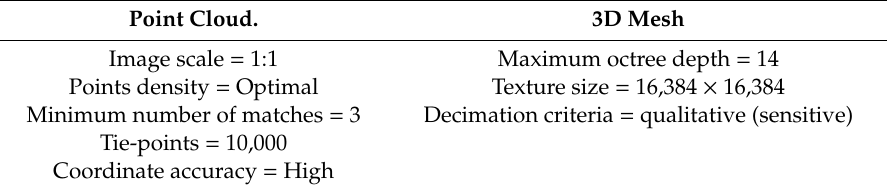
Table 3. Settings used in Pix4D software.